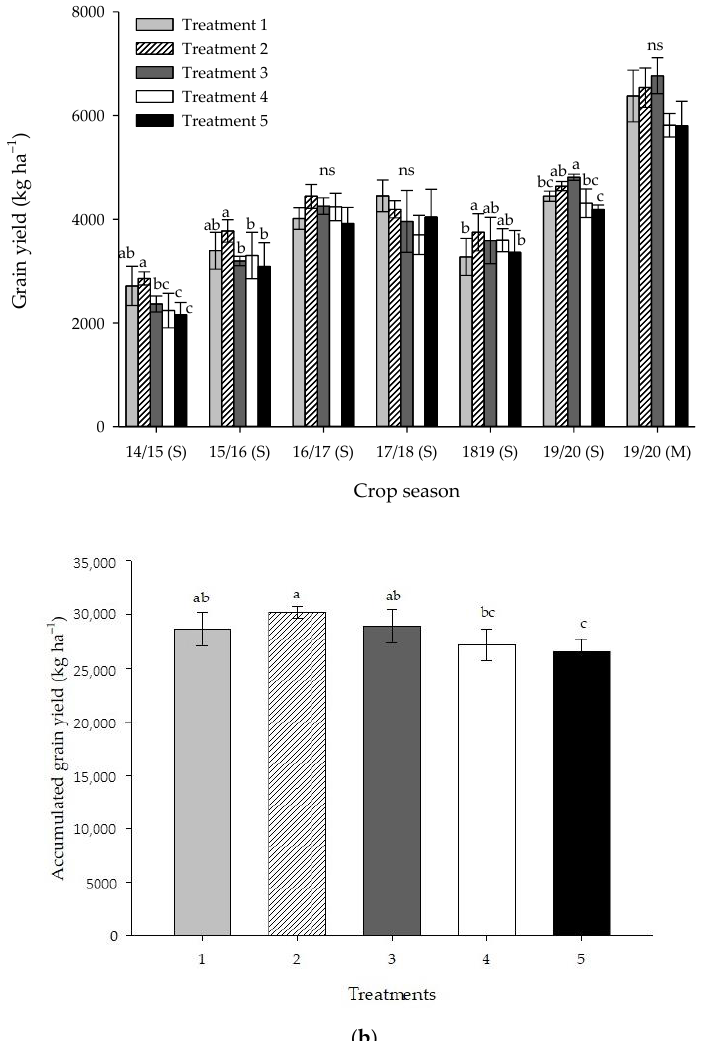
Figure 2. ( a ) Grain yield in each season; ( b ) Accumulated grain yield in six years of cultivation. S: soybean; M: maize; Treatment 1: full correction + maintenance at seed furrow; Treatment 2: full correction incorporated + maintenance at seed furrow; Treatment 3: full correction at seed furrow + maintenance broadcasted; Treatment 4: full correction + maintenance both broadcasted; Treatment 5: gradual correction + maintenance at seed furrow. Means followed by different letters differ by Tukey test at 10% error probability; ns: not significant. Error bars (±) indicate the standard deviations of 3 replicates.